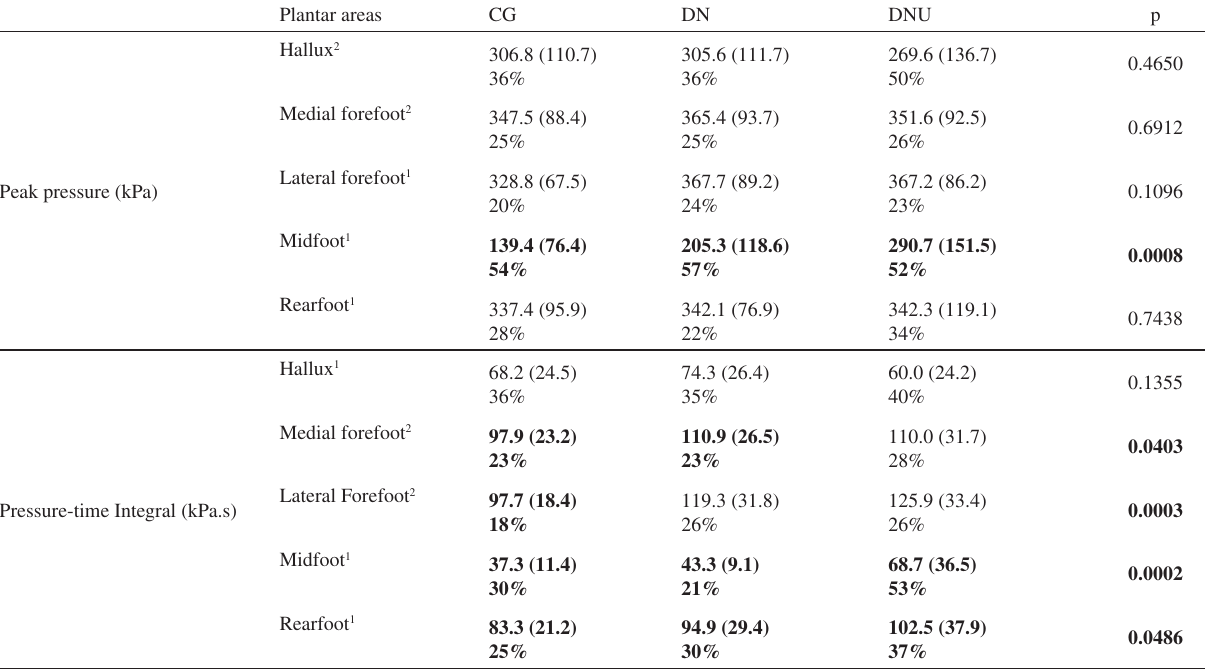
Table 2 - Plantar pressure